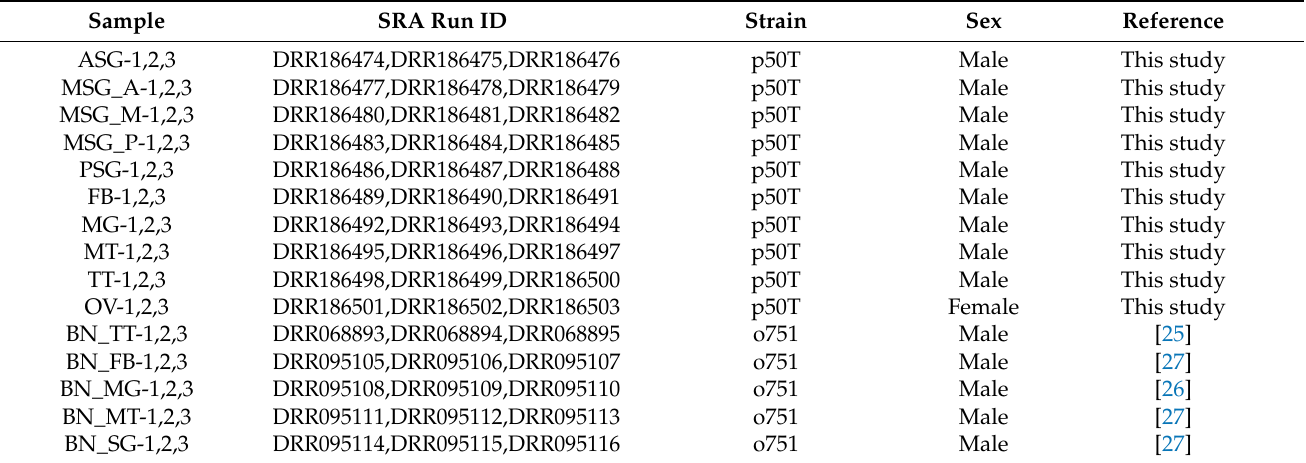
Table 1. Samples for RNA-seq and run accession